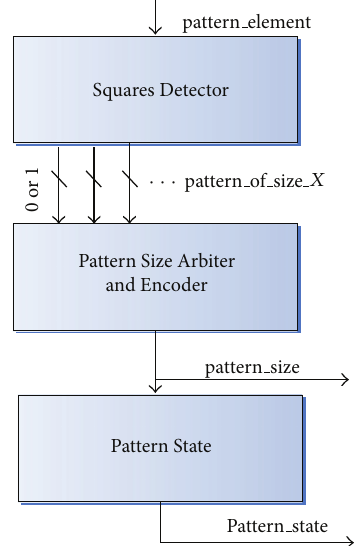
F 3: Diagram for the Megablock Detector.